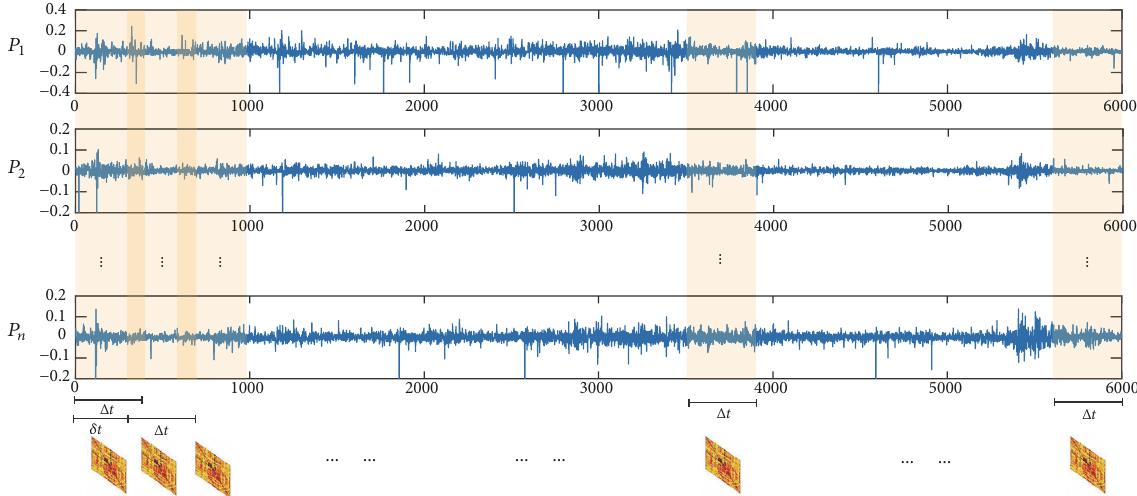
Figure 1: The illustration of the method to construct stock market networks. The network is constructed by calculating the correlations between the stocks return prices Pi (i = 1,2, .. ., N) inside a time window of length (cid:2) t. Next, by shifting this time window by amounts 𝛿 t until the end of the database is reached, we obtain the network